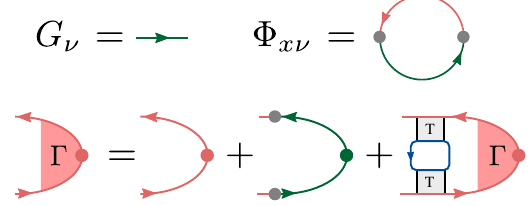
FIG. 6. Functional describing the exciton-photon interaction Φ G ; G ν (cid:3) and the vertex correction Γ for polaritons with x ν ½ x photon propagators represented by green (dark gray)